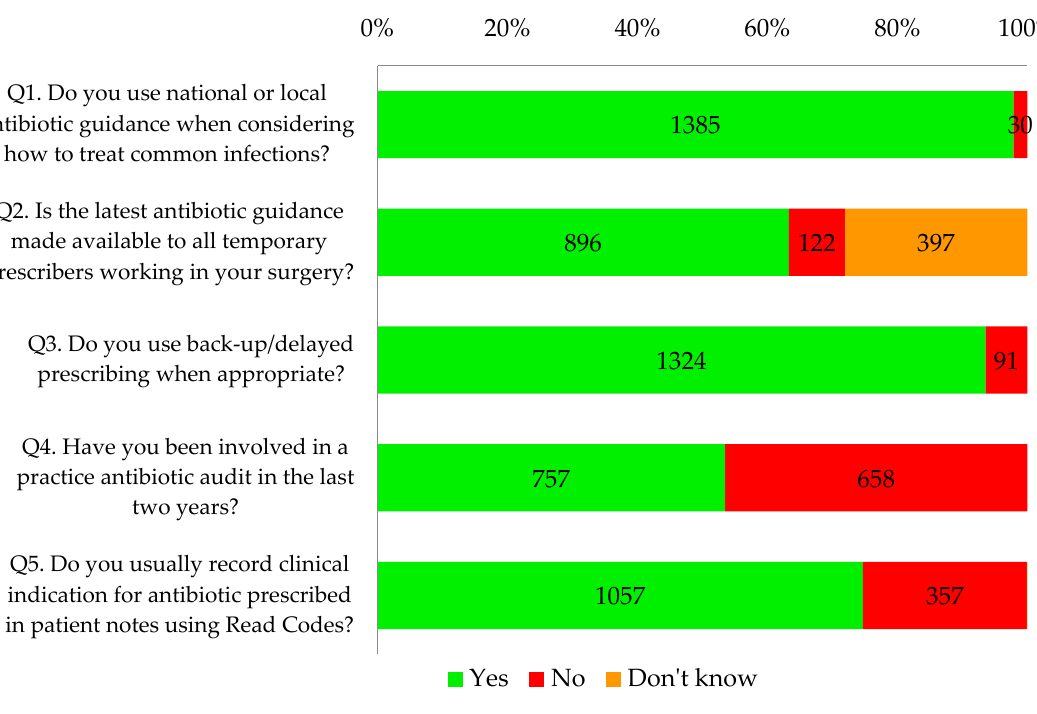
Figure 3. A visual breakdown of the five questions from the section entitled “What would be good practice now”.